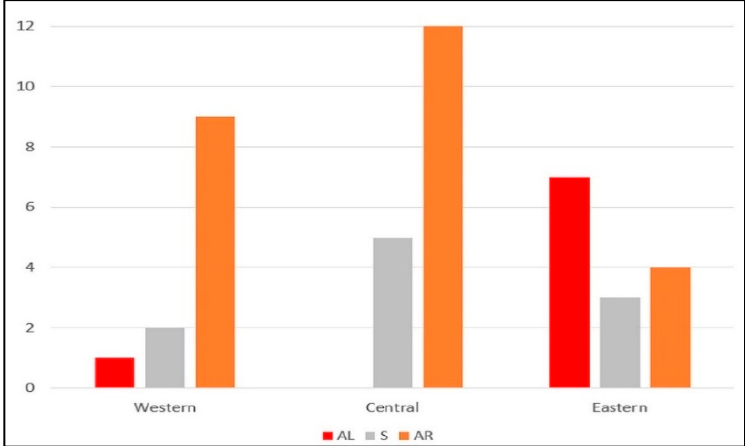
Figure 8. The number of cases exhibiting each rainfall distribution pattern by group.